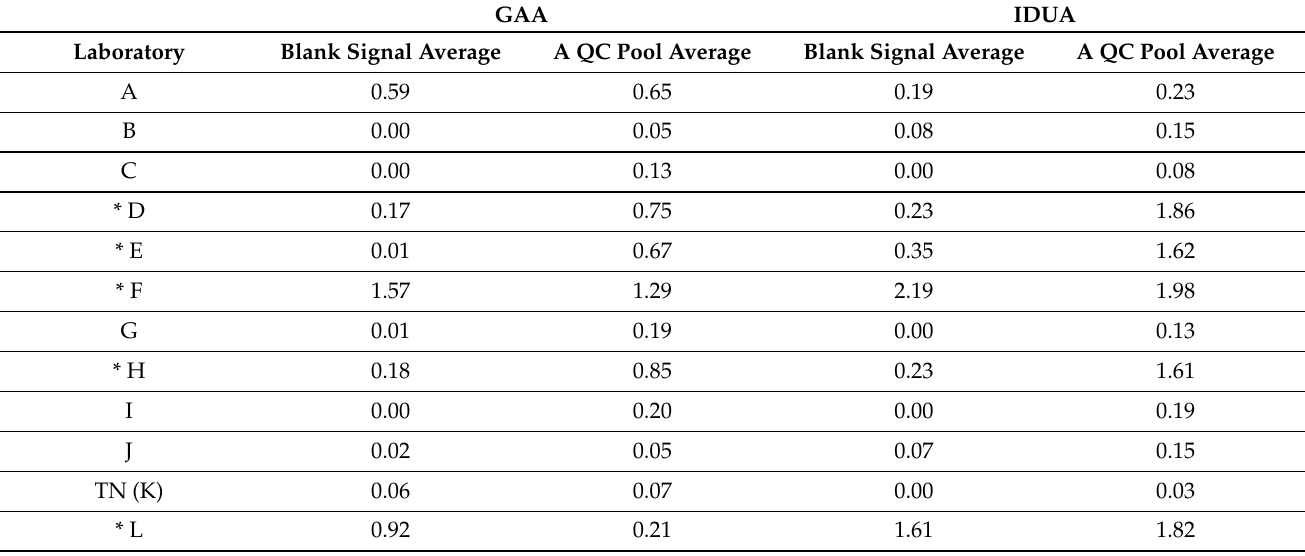
Table A2. Average blank signals versus QC pool enzyme activities ( µ